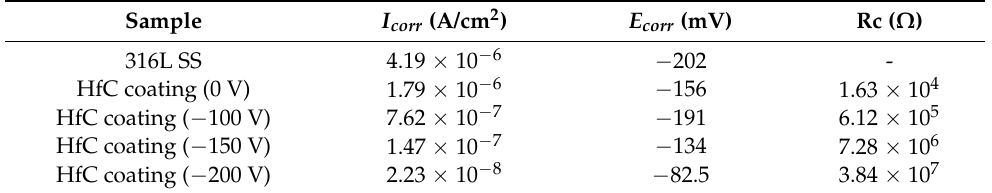
Table 2. Corrosion parameters in PBS solution for HfC coatings deposited at different bias voltages.